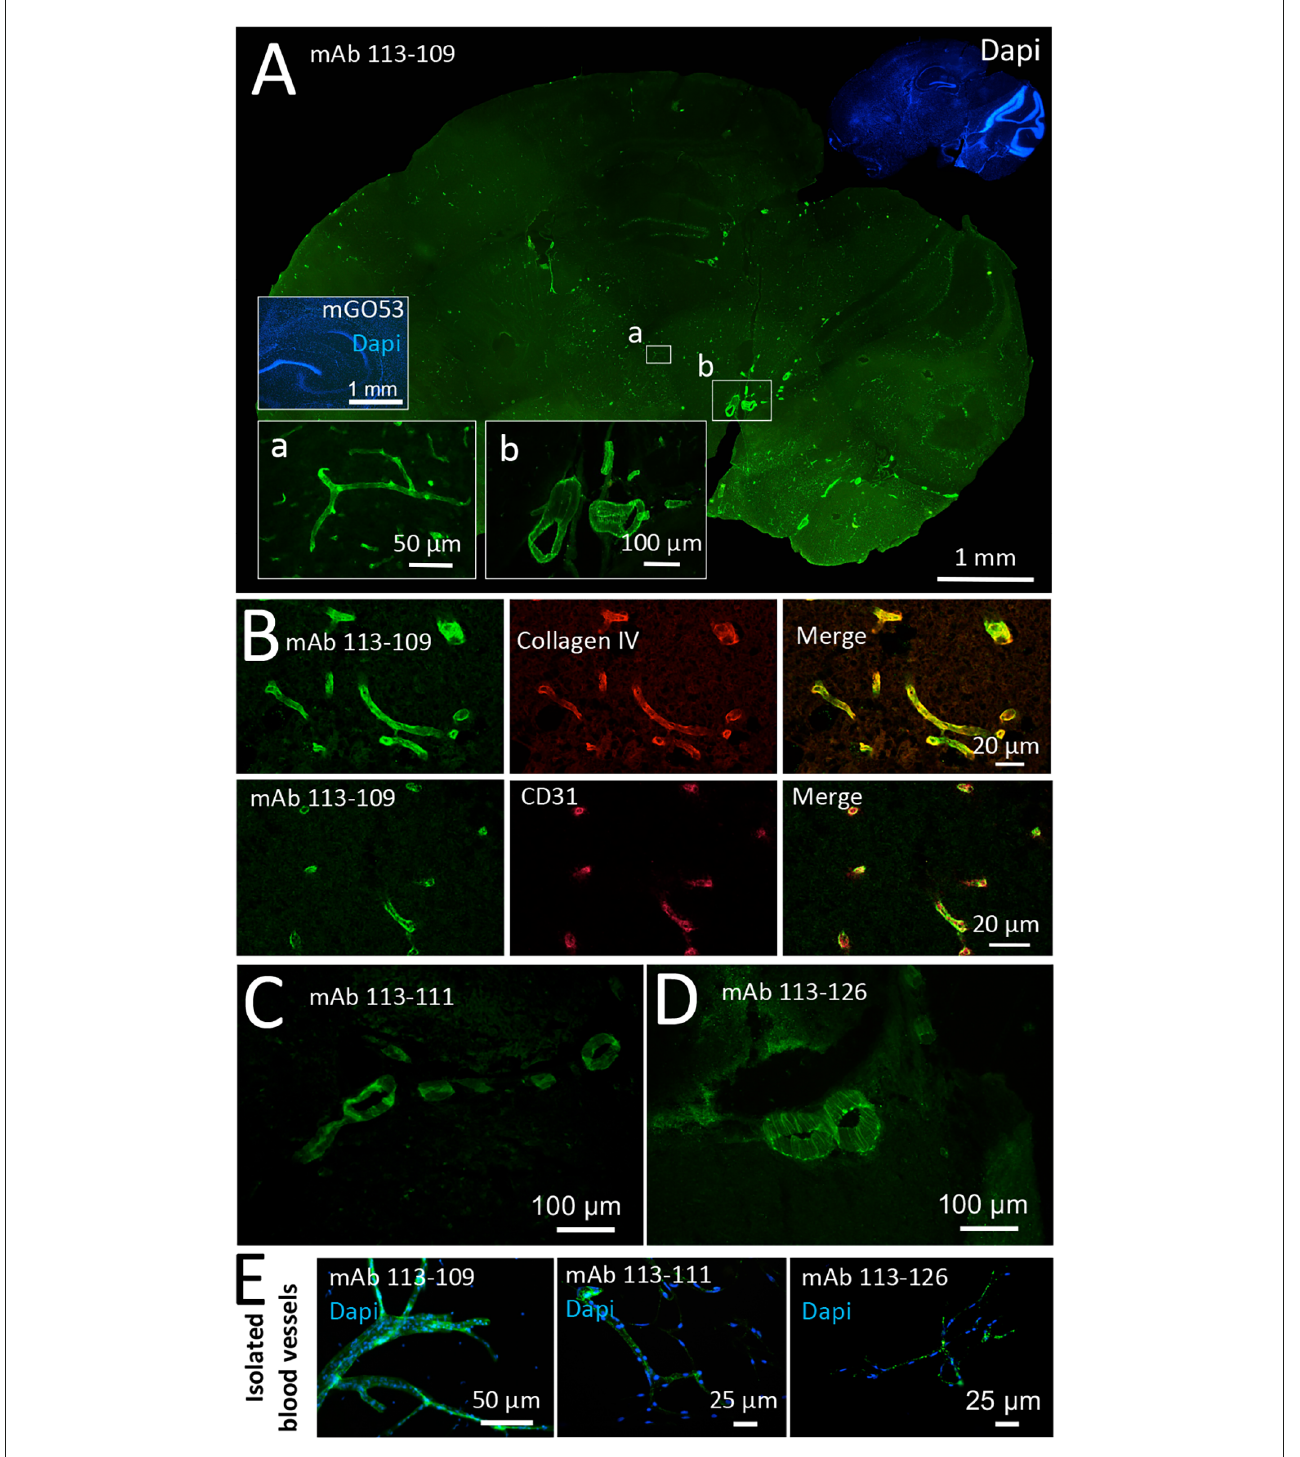
FIGURE1 Recombinant monoclonal antibodies from a GABA A R encephalitis patient bind to brain blood vessels. Sections from unfixed and unpermeabilized adult mouse brains were incubated with 5 µ g/ml of the respective monoclonal antibodies obtained from a patient diagnosed with GABA A R encephalitis. Visualization of tissue binding was performed using a FITC-coupled anti-human IgG secondary antibody. (A) Sagittal brain section incubated with human monoclonal antibody (mAb) 113-109. Prominent staining of blood vessels of all diameters in all brain regions was obtained (see insets a and b). Incubation with control mAb mGO53 yielded no tissue staining (inset). (B) Double stainings against Collagen IV (upper panel) and CD31 (lower panel) confirm immunoreactivity of mAb 113-109 to blood vessels. (C) Sagittal brain section incubated with mAb 113-111. Prominent staining of large blood vessels was obtained in all brain regions (the area between the cerebellum and midbrain is shown). (D) Sagittal brain section incubated with mAb 113-126. Again, prominent staining of large blood vessels in all brain regions was obtained (the area between the cerebellum and midbrain is shown). (E) Stainings of isolated brain blood vessels. Blood vessels were obtained from homogenized mouse brains by combinatory centrifugation and filtering steps. A 30-100 µ m filter size fraction incubation with all three antibodies resulted in clear staining of the vessels within this fraction. Note that the diameter of mounted blood vessels is subject to shrinking artifacts during the staining